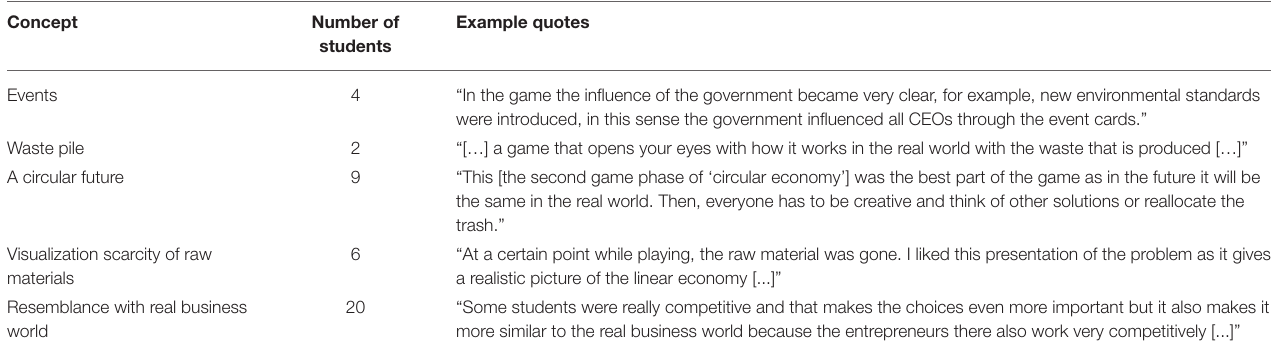
TABLE 8 | Aspects listed in the reflection reports related to level of reality in the